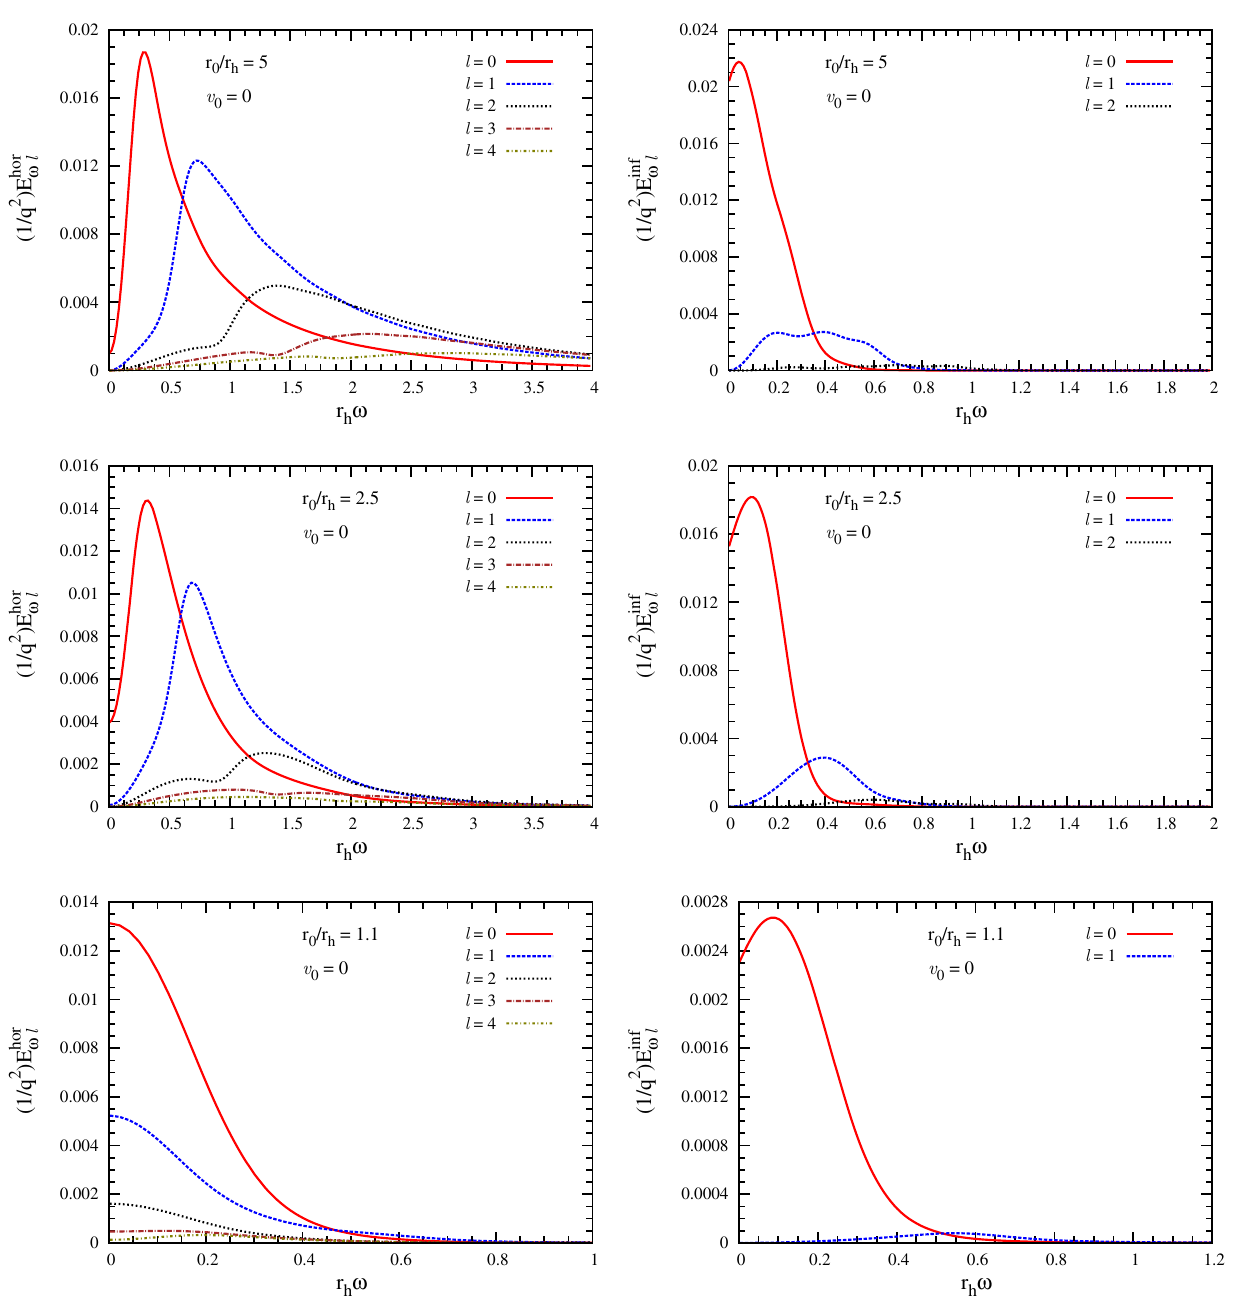
Fig. 3 Numerical estimates of the spectra of the emitted energy, E hor ω and (38) (with B = 0), for a source infalling from rest ( v 0 = 0) at l positions r 0 = 5 r h (plots at the top), r 0 = 2 . 5 r h (plots in the middle) (plots on the left) and E inf ω (plots on the right), as functions of ω , l and r 0 = 1 . 1 r h (plots at the bottom) for selected values of the multipole number, obtained from Eqs. (35) horizon as the source approaches it. The spectrum of energy , (plots on the right in Fig. 2) starts emitted to infinity, E inf ω l from a non-vanishing finite value (at ω = 0) and goes to zero for high frequencies. The contribution of higher